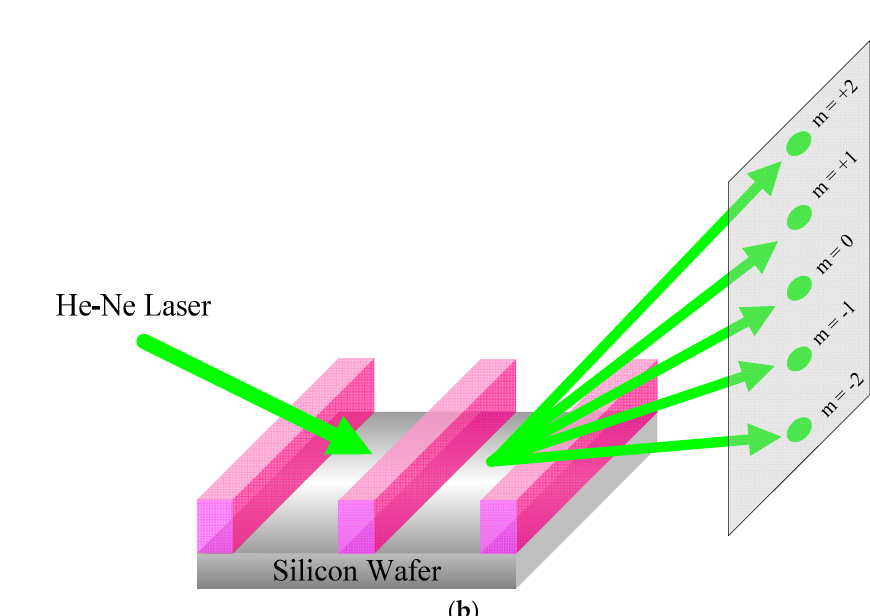
Scheme 2. Reflective diffraction patterns through line array of DGs for a monochromatic input wave for ( a ) TE and ( b ) TM polarization.